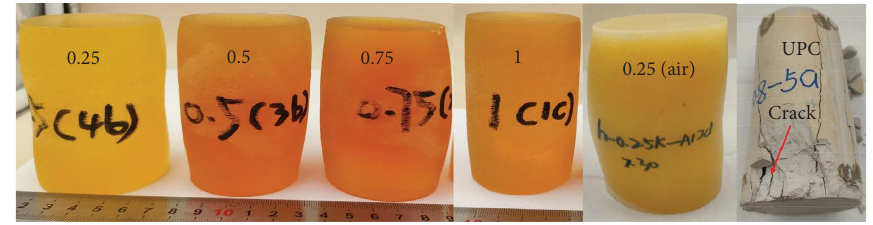
Figure 13: Epoxy resin after compression and broken UPC